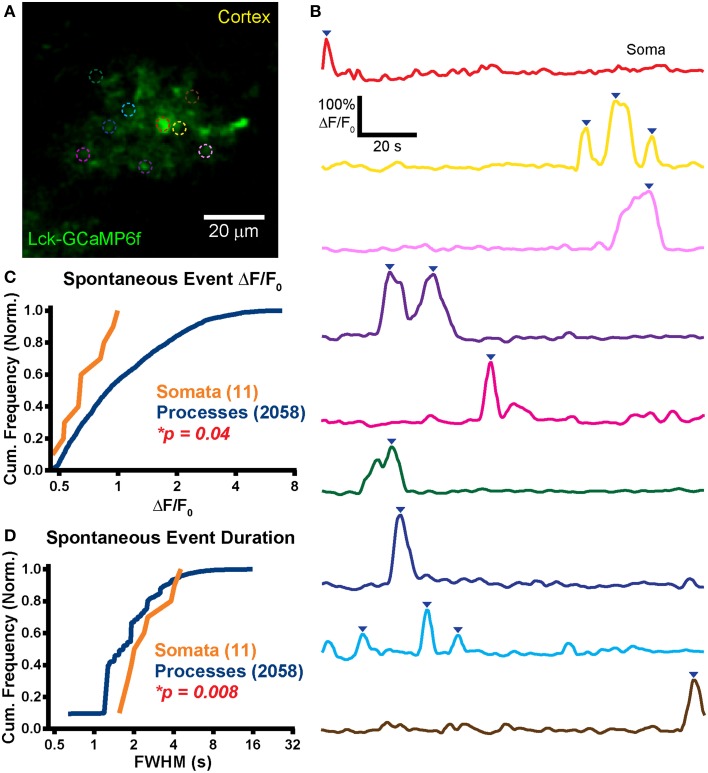
Large spontaneous events in astrocytic processes but not somas. (A) Example mean calcium activity projection image of a cortical astrocyte expressing Lck-GCaMP6f in an acute brain slice obtained from a P34 rat. As in Figure 4, ROIs are denoted by dashed circles. (B) ΔF/F0 traces of ROIs shown in (A). Line colors in (B) correspond to dashed circle colors in (A). Inverted blue arrows mark peaks that reached threshold and were included as events for analysis. “Merged” events were counted as a single long event (see green ROI). (C) A cumulative histogram displaying the relative frequency (event counts normalized by total events in each structure) of spontaneous event peak ΔF/F0 values. The total events in each structure is shown in parentheses next to the structure name. (D) A cumulative histogram displaying spontaneous event duration. Soma data is shown in orange and process data in blue. The distribution of each measurement was compared between somas and processes. The calculated p-value from a Kolmogorov–Smirnov test is shown in each plot. Red text denotes significance and black text denotes no significance detected at a level of p < 0.05.